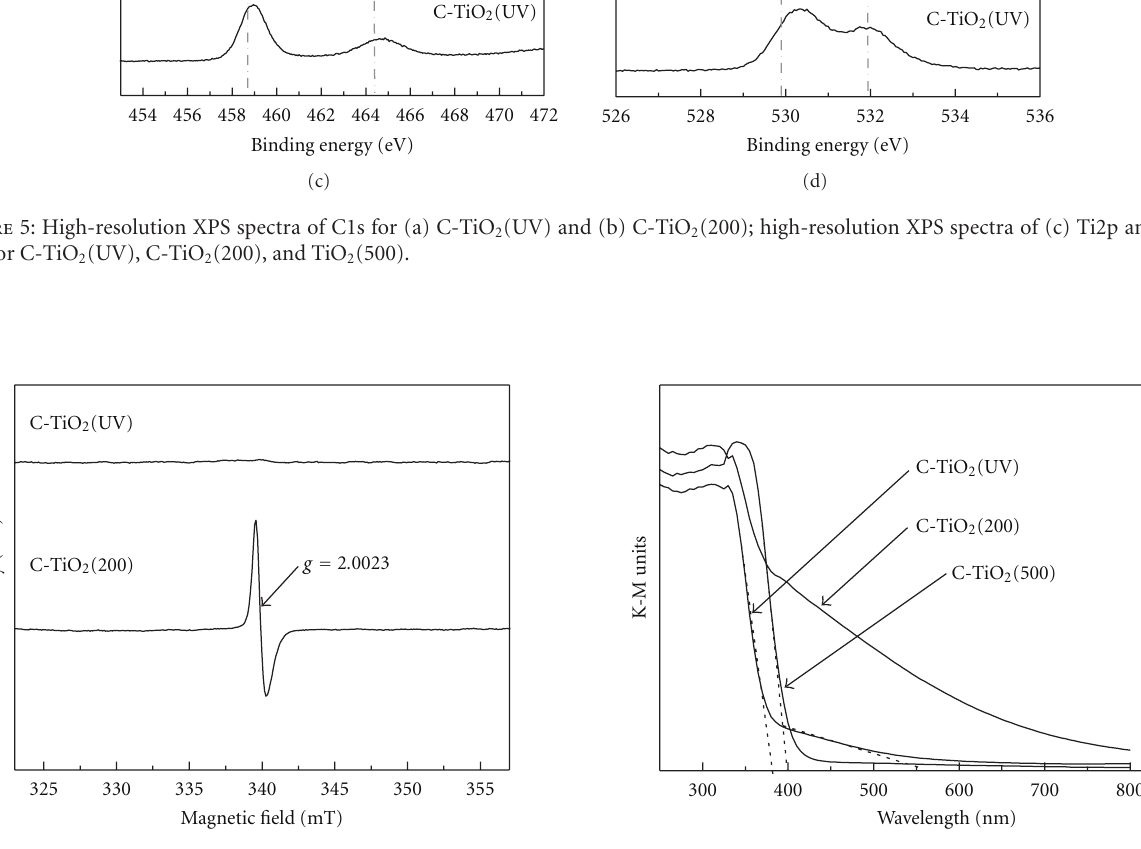
Figure 7: UV-Vis di ff use reflectance spectra of C-TiO 2 (UV), C- TiO 2 (200), and TiO 2